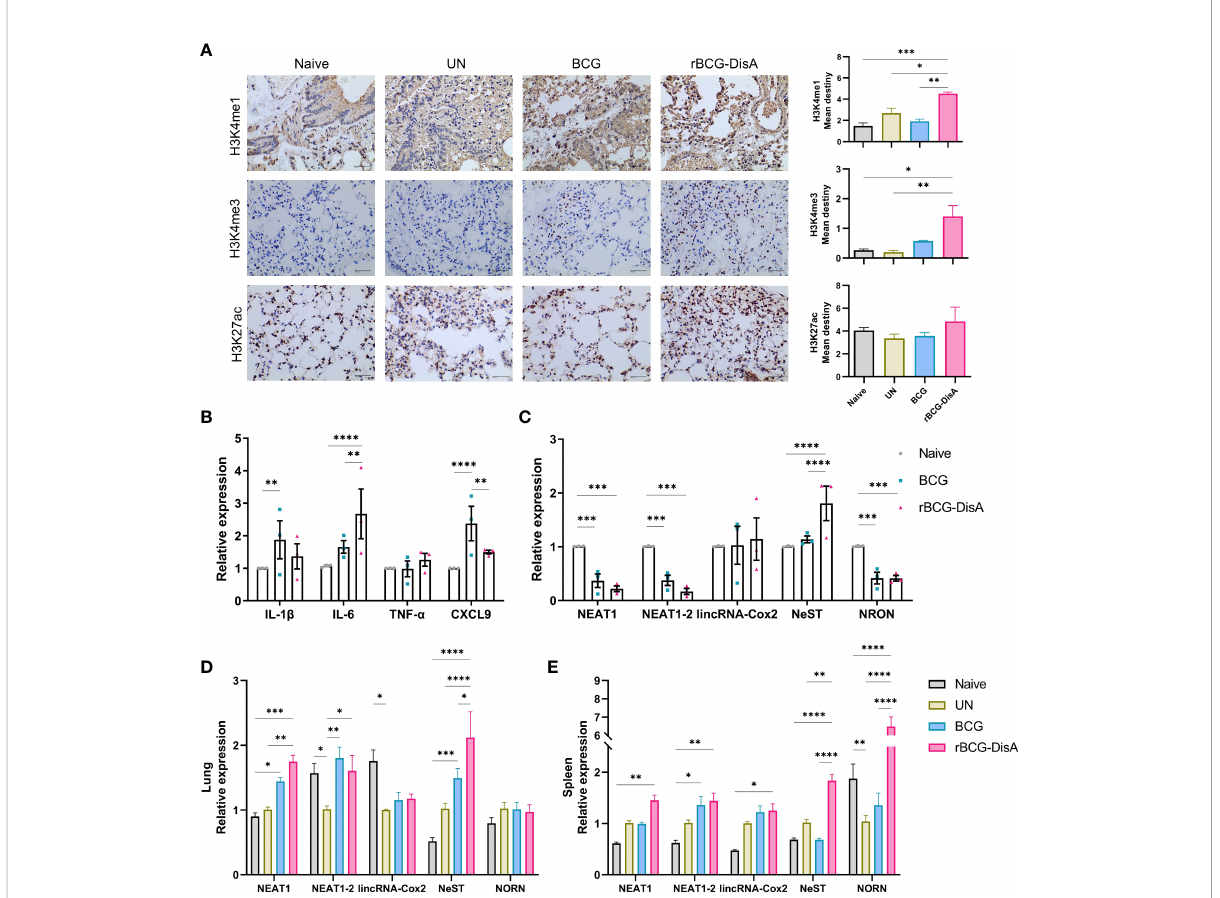
FIGURE 3 Expression of lncRNA and histone modi fi cations in BM cells, lung and spleen of mice. Mice were vaccinated by i.v BCG and rBCG-DisA for 8 weeks (for BM cells isolation) and 12 weeks (for infection). Then, mice were infected with M. tuberculosis by i.n route, normal mice (Naïve) and M. tuberculosis infected mice without immunization (UN) were used as control. (A) At 6 weeks post infection, immunohistochemical analysis of H3K4me1, H3K4me3, and H3K27ac expression in the lung tissue (left). Quantitative analysis of H3K4me1, H3K4me3, and H3K27ac expression by Image J (right) ( n =3). (B, C) At 8 weeks after BCG and rBCG-DisA i.v immunization, the expression of indicated cytokines (B) and non-coding RNA (C) in BM cells was detected by quantitative RT-PCR ( n =3). (D, E) At 6 weeks post infection, immune responses were detected. Levels of indicated noncoding RNA in the lung (D) and spleen (E) were assayed by quantitative RT-PCR ( n =3). (* P < 0.05, ** P < 0.01, *** P < 0.001, **** P <